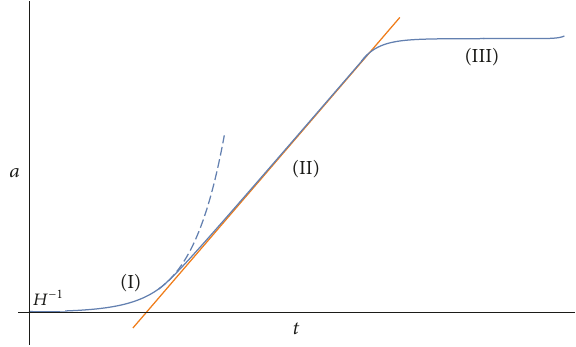
Figure 8: The scale factor of the new scenario. Notice that there are three stages of the evolution of the scale